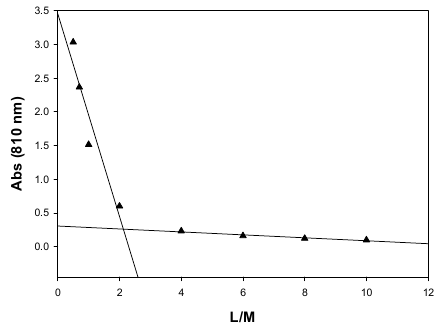
Figure 3. Spectrophotometric titration of V IV O 2+ with naringin at pH = 9, under nitrogen atmosphere. L/M, naringin/ V IV O 2+ molar ratio. Absorbance at 810 nm.